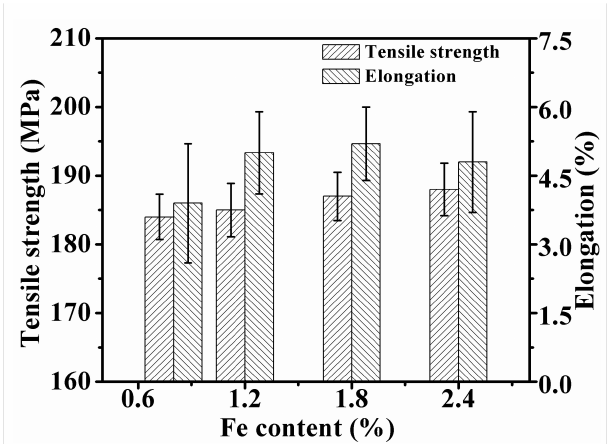
Figure 6. Effect of Mn/Fe ratio on tensile mechanical properties of